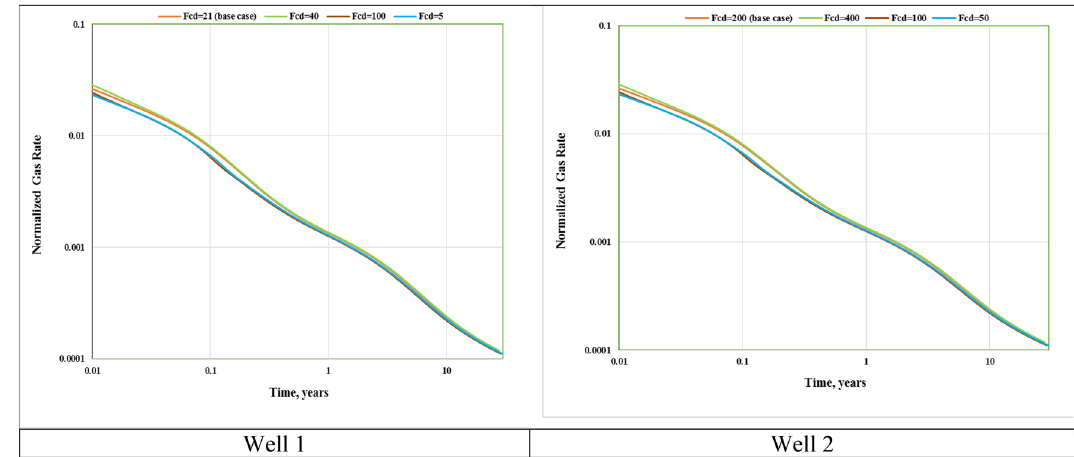
Fig. 11 Fracture conductivity